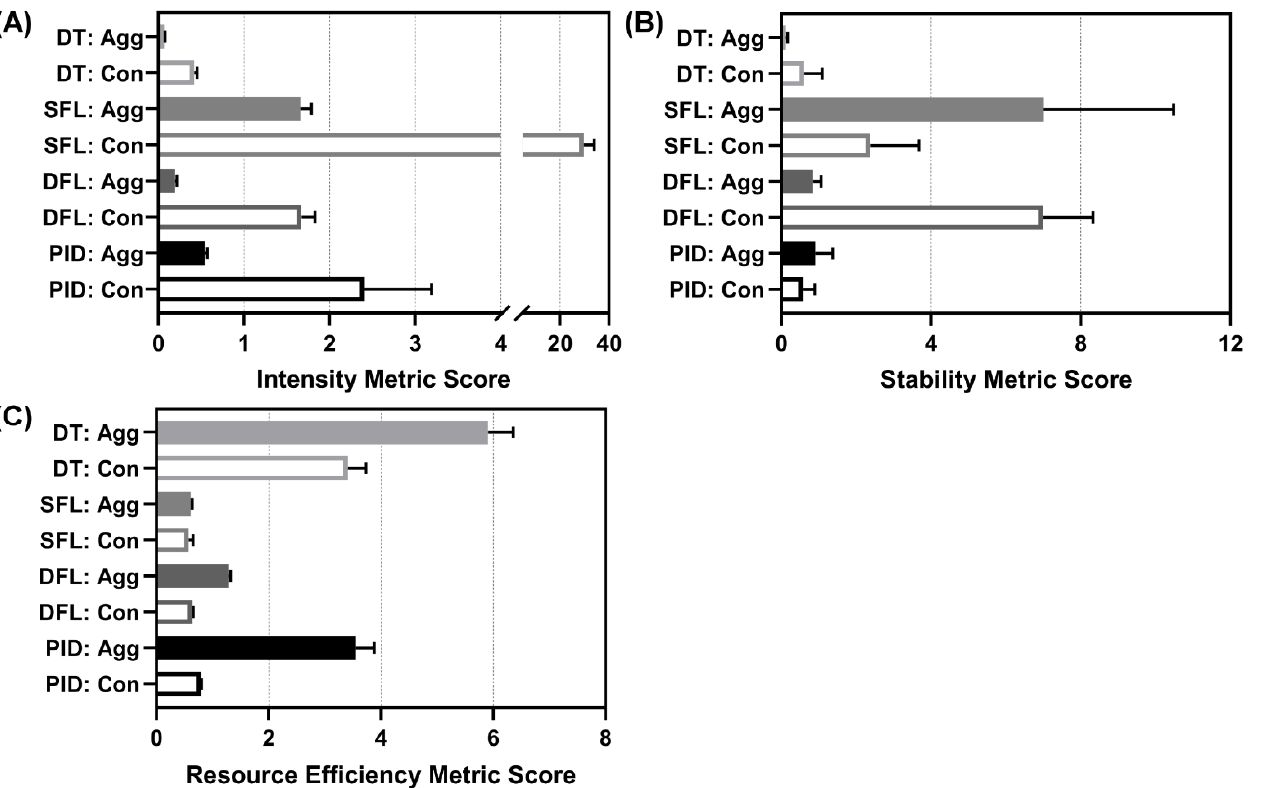
Figure 8. Aggregate metrics for each controller. Results for three developed aggregate metrics are shown for each controller type (DT = decision table; SFL = single-input fuzzy logic; DFL = dual-input fuzzy logic; PID = proportional–integral–derivative controller) and configuration (Agg = aggressive; Con = conservative): ( A ) intensity (note the broken x -axis), ( B ) stability, and ( C ) resource efficiency (lower is better for each). Each metric component is detailed in Section 2.5. Average results are shown for three subject variability runs. Error bars denote the standard deviation.